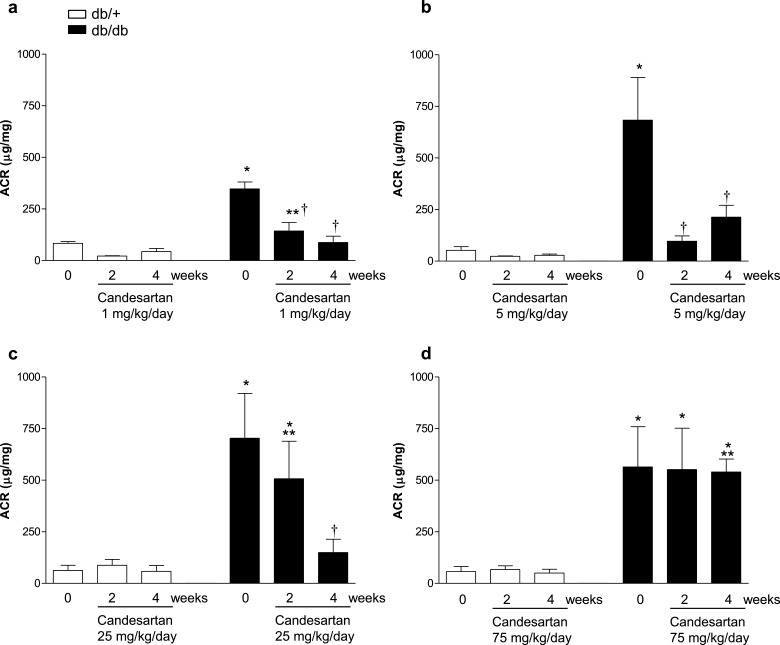
Intermediate to high, but not ultra-high, dose of candesartan ameliorates albuminuria in db/db miceUrinary albumin was assessed in db/+ and db/db mice at baseline (0 time point) and following 2 and 4 weeks of vehicle or candesartan daily subcutaneous injections. Mice were treated with vehicle or candesartan at 1 mg/kg/d (a); 5 mg/kg/d (b); 25 mg/kg/d (c); 75 mg/kg/d (d). Albuminuria was expressed as albumin (μg/ml):creatinine (mg/ml) ratio. Results are presented as mean ± S.E.M. of 5–7 mice in each group. *P<0.05 compared with vehicle-treated db/+; **P<0.05 candesartan-treated db/db compared with db/+ of corresponding week; †P<0.05 candesartan-treated db/db compared with vehicle-treated db/db.